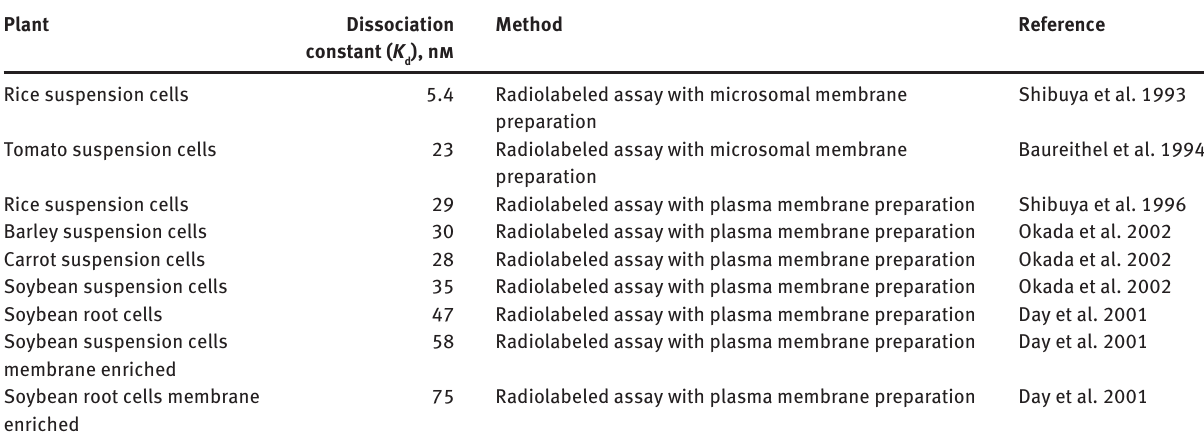
Table 2 Chitin binding kinetic parameters in various plant